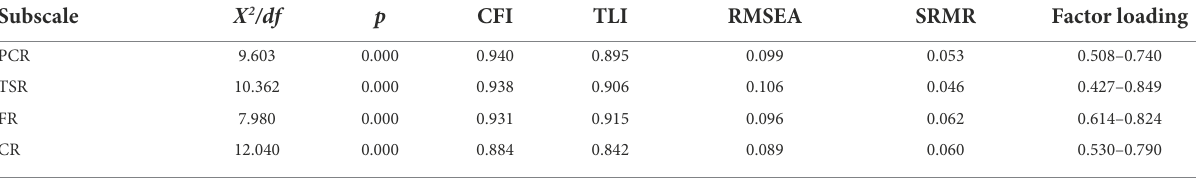
TABLE 3 Construct validation analysis with CFA analysis for promotion-prevention focus model at each context. Subscale